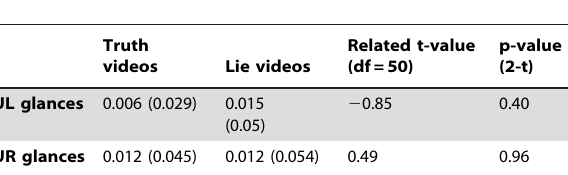
Table 3. The mean frequencies (per second, SD in parentheses), related t-tests and p-values comparing of UL and UR glances in the Lie and Truth